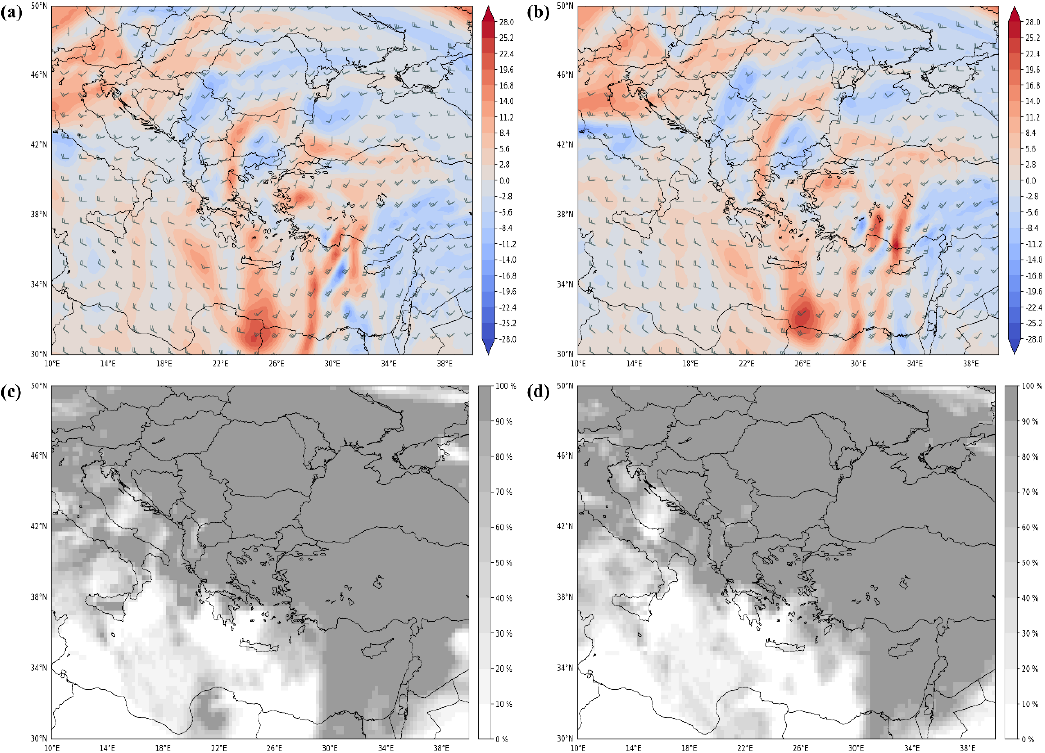
Figure A4. 500 hPa relative vorticity (shading; 10 −5 s −1 ) and wind barbs ( a , b ), and total cloud cover ( c , d ) from the 0.25° × 0.25° ERA5 reanalysis data on 22 February 2013, 0600 UTC ( a , c ) and 0800 UTC ( b , d ).